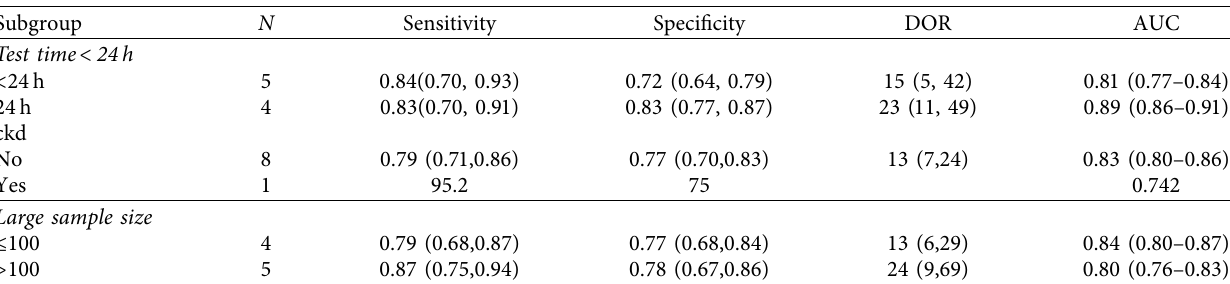
Figure 3: Summary receiver operating characteristic (SROC) graph with 95% confidence region and 95% prediction region for the diagnosis value of CI-AKI by KIM-1. Table 3: Subgroup